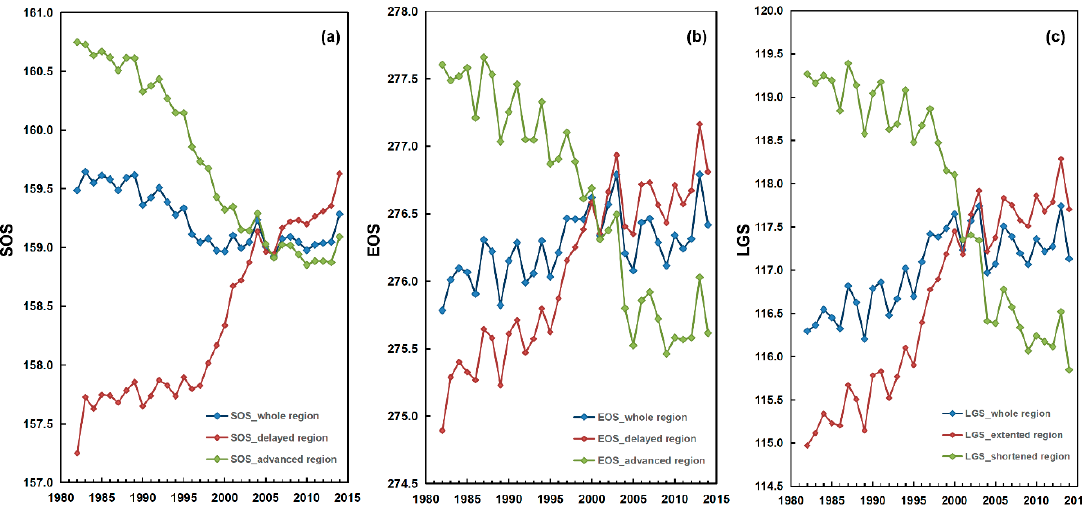
Figure 5. The dynamics of phenology from 1982 to 2014 in the Qilian Mountains. ( a ) The dynamics of the SOS in different regions; ( b ) the dynamics of the EOS in different regions; ( c ) the dynamics of the LGS in different regions.